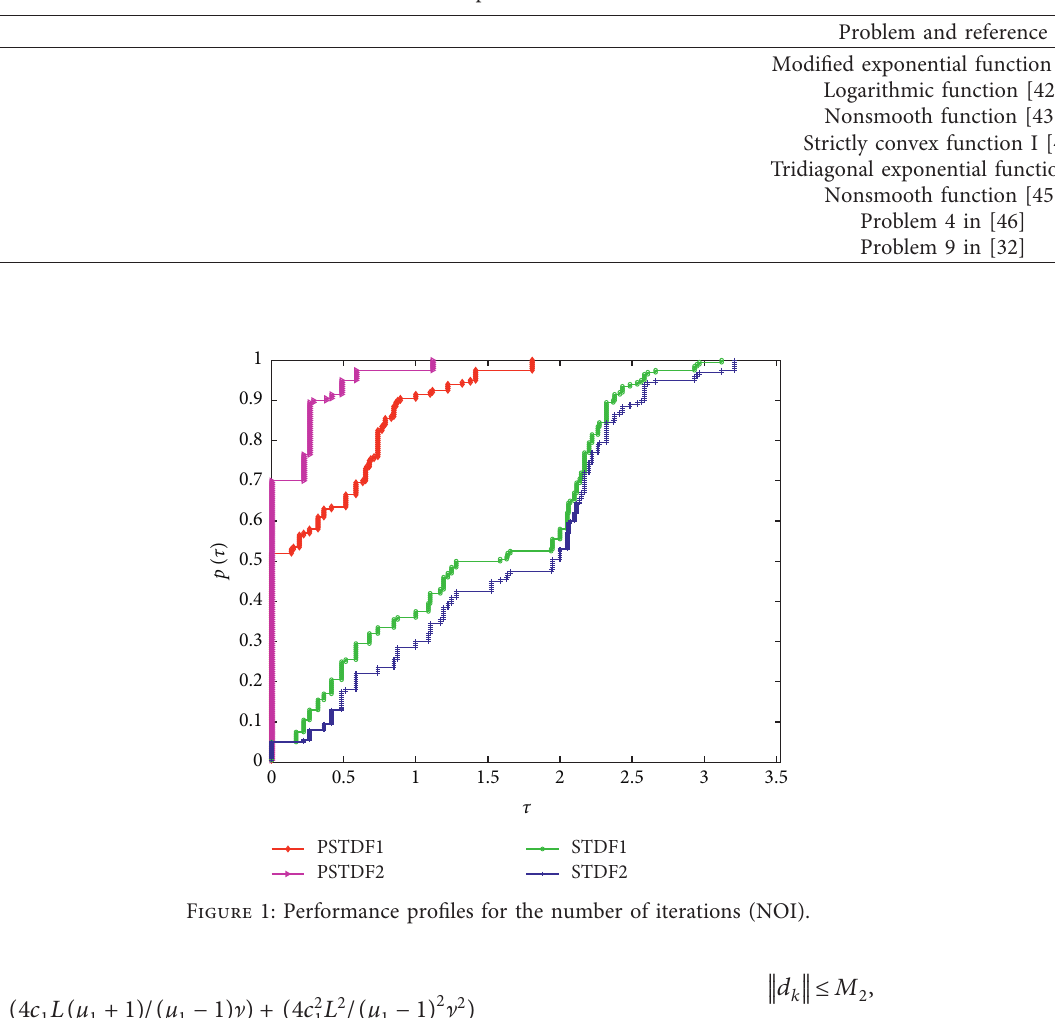
Table 1: List of test problems with references.